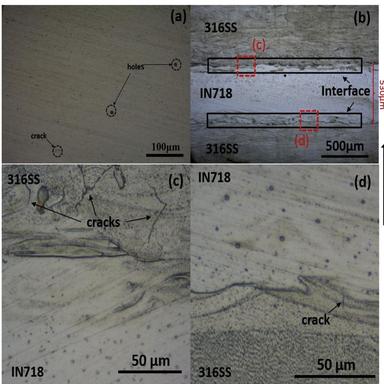
Characteristic optical micrographs of the polished (a) and etched (b, c, d) section of built part.